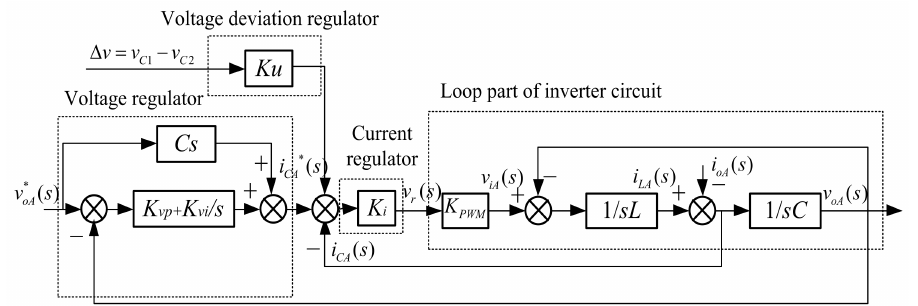
Figure 10. VSSG control block diagram with neutral voltage deviation